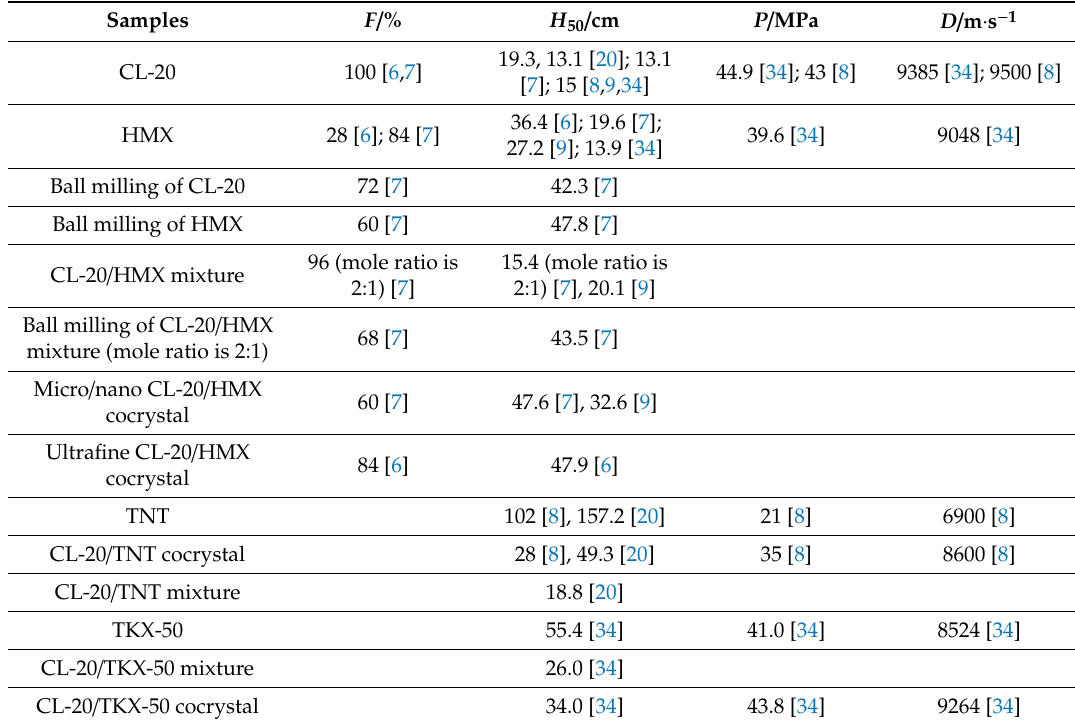
Figure 15. DSC curves of di ff erent samples [6], with permission from Han Neng Cai Liao, 2020. Table 8. The mechanical sensitivities of di ff erent